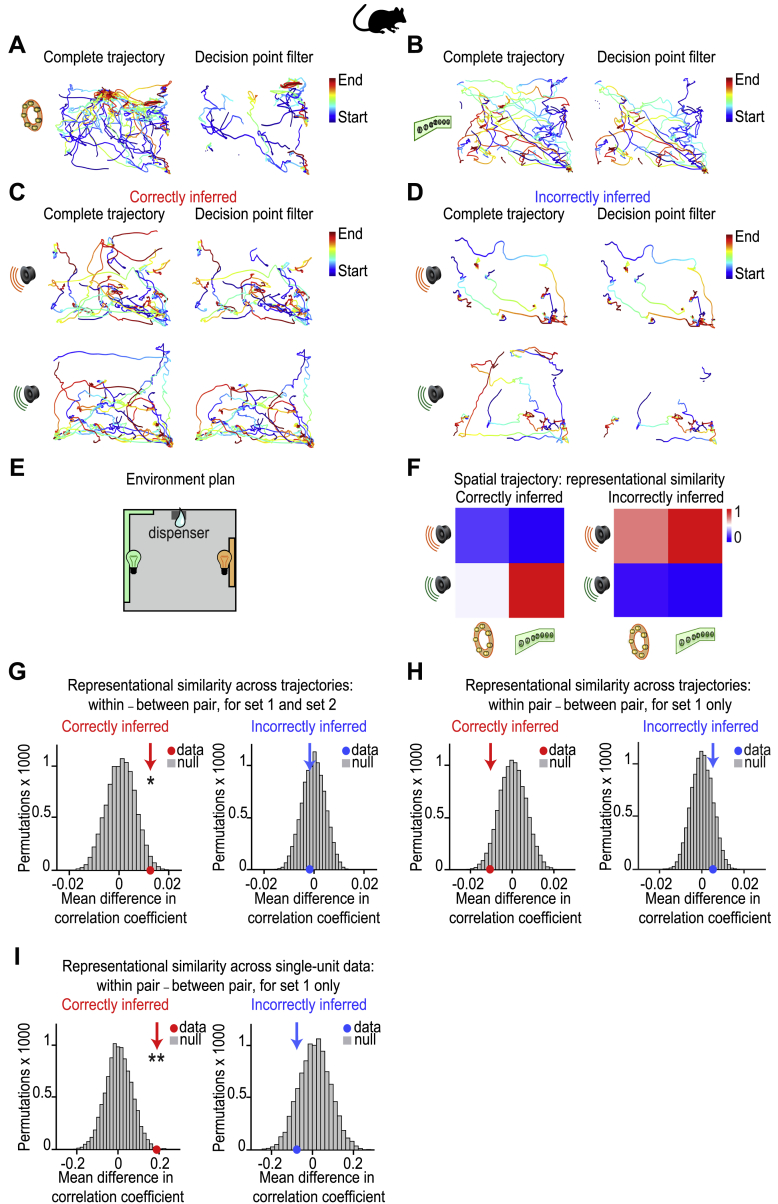
In Mouse dCA1, Representational Similarity between Activity Patterns for Xn and Yn in Set 1 Is Not Explained by Spatial Trajectory, Related to Figures 3, 4, 5, and 6In mice: (A-D) Overlaid trajectory for an example mouse during visual cues (Yn) and auditory cues (Xn). Blue indicates the start of the trajectory and red indicates the end of the trajectory. Left hand panels: complete trajectories during the cue. Right hand panels: trajectories filtered by the “decision point” of the mouse, as applied in Figures 3, 4, 5, and 6. The “decision point” of the mouse is defined as the time point where the speed of the mouse was below 5cm/s prior to visiting the outcome area on that trial (see STAR Methods). Filtering the trial data by the decision point eliminated time periods where the mouse was at or near the dispenser, thus controlling for spatial confounds in set 1. (A) Trajectories during visual cue Y1 from set 1. (B) Trajectories during visual cue Y2 from set 2. (C) Trajectories during auditory cues Xn from set 1 and 2 for correctly inferred trials. (D) Trajectories during auditory cues Xn from set 1 and 2 for incorrectly inferred trials. (E) Schematic showing birds-eye view of the open field used for the example mouse shown in A-D. (F) The average representational similarity matrices (RSMs) across recording days for spatial trajectories during cues Xn and Yn, after filtering by the decision point and dividing the data by performance in the inference test. Rank-transformed and scaled between [0 to 1] for visualization purposes. (G-H) The average representational similarity for ‘within set’ versus ‘between set’ spatial trajectories across cues Xn and Yn, after filtering by the decision point and splitting by performance in the inference test. The group mean was compared against a null distribution generated by permuting the identity labels assigned to the auditory cues Xn. (G) Across both set 1 and 2, spatial trajectories during the auditory cues Xn significantly predicted the trajectories for the associated visual cue Yn, ([within set XnYn correlation] – [between set XnYn correlation], ‘correct inference’ p = 0.014, ‘incorrect inference’ p = 0.687). (H) Across set 1 alone, spatial trajectories during the auditory cues Xn did not significantly predict the trajectories for the associated visual cue Yn, ([within XnYn correlation] – [between XnYn correlation], ‘correct inference’ p = 0.957, ‘incorrect inference’ p = 0.151). (I) Across set 1 alone, the single-unit activity in neurons recorded from dCA1 during auditory cues Xn significantly predicted the activity patterns for the associated visual cue Yn during correct but not incorrect inference ([within set XnYn correlation] – [between set XnYn correlation]). The group mean was compared against a null distribution generated by permuting the identity labels assigned to the auditory cues Xn (‘correct inference’ p = 0.002, ‘incorrect inference’ p = 0.865). Given the absence of significant spatial correlations for set 1 shown in H, this result shows that during correct inference, dCA1 ensemble activity predicted the associated cue Yn over and above the spatial location of the animal.